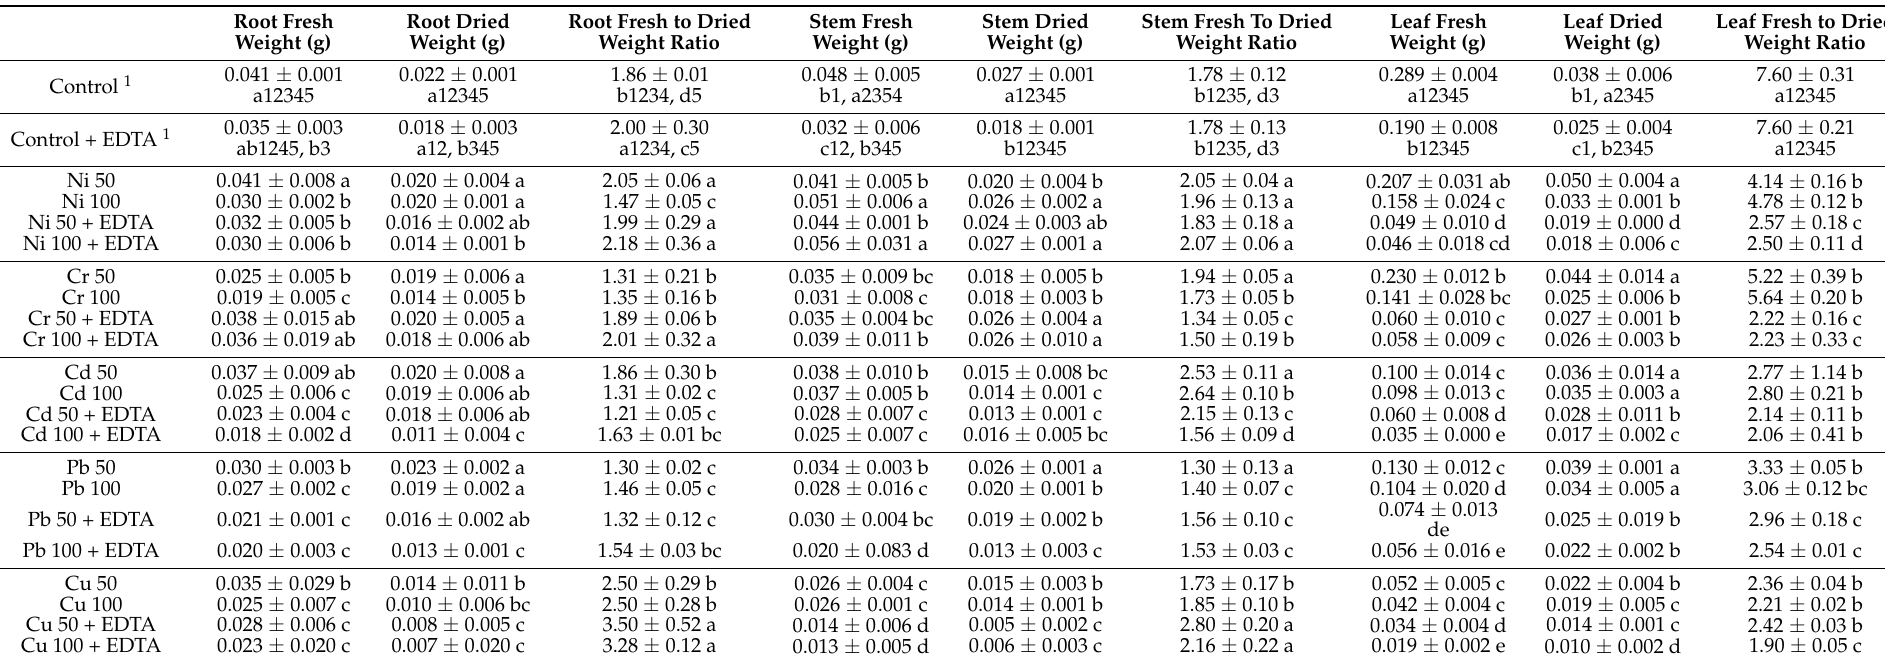
Table 2. Biomass production by Catharanthus roseus at different metal concentrations with and without